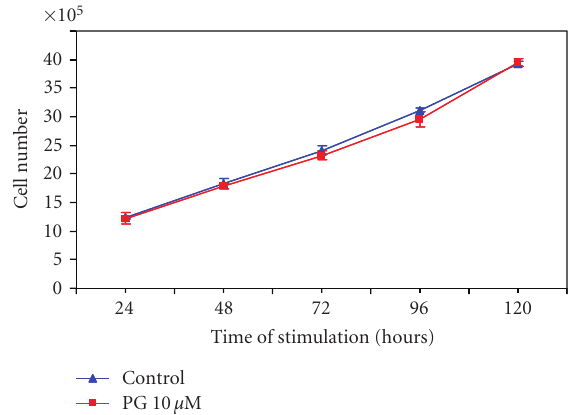
Figure 3: Growth control of the RIN-14B cells by the CCK-2 receptor agonist pentagastrin (PG). Cells were grown for up to 120 hours in the presence of 10 μ M PG. Medium and PG were changed daily and cells were counted daily for up to 5 days. Results are the means ± SE of 5 wells per point in each group.